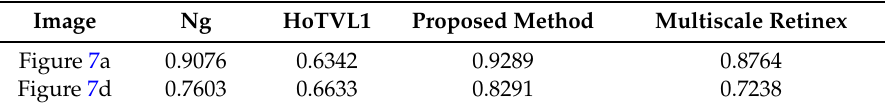
Table 1. SSIM of the four methods.